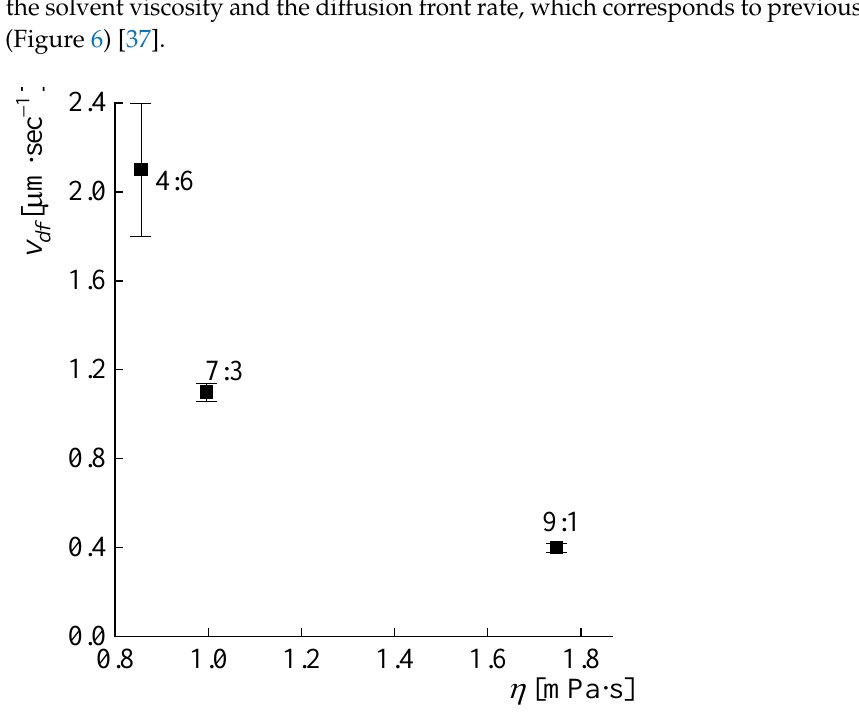
Figure 7. ( a ) X-ray diffraction patterns of ABPBI fibers in equator and meridian directions before (B) and after (A) partial dissolution at reflection (R) and transmission (T) modes; ( b ) ABPBI fiber before (I) and after (II) partial dissolution, and the powder (III) images in linear crossed polaroids. Thus, the dissolution kinetics is largely determined by the dissolution rate of the more oriented phase presented in the polymer fiber. This occurs most rapidly in the meth- anol-enriched mixture, which is probably associated with a higher concentration of meth- ylate in the dissolution zone. 3.4. Rheology of Concentrated Solutions The rheological behavior of solutions with the same ratios of DMSO:MeOH as before at a constant KOH content was studied in detail for 3, 7, and 9% solutions at 20 °C. The corresponding data are shown in Figure 8.